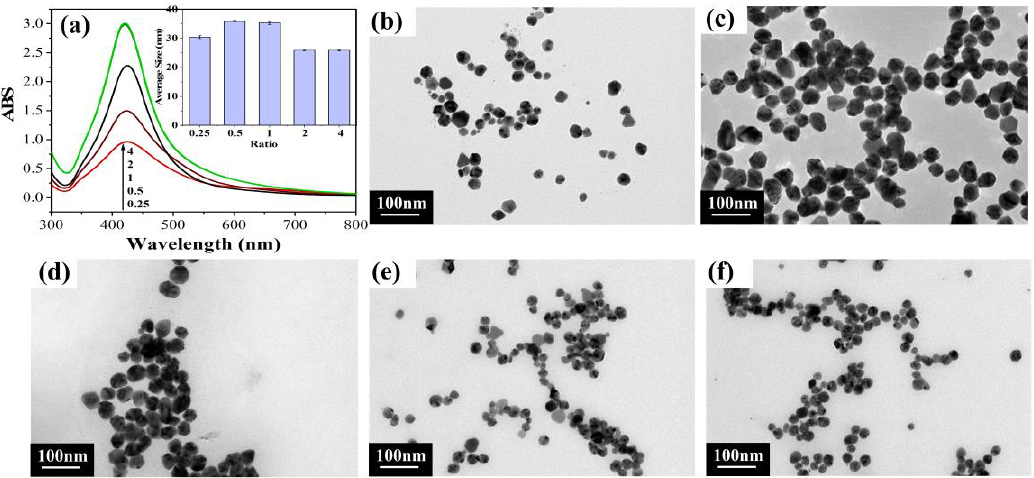
Figure 1. Results for different DAC to silver ammonia solution mass ratios: ( a ) UV-vis spectra and (inset) average size histogram; ( b – f ) TEM images of DAC to silver ammonia solution mass ratios of 0.25–4, respectively.